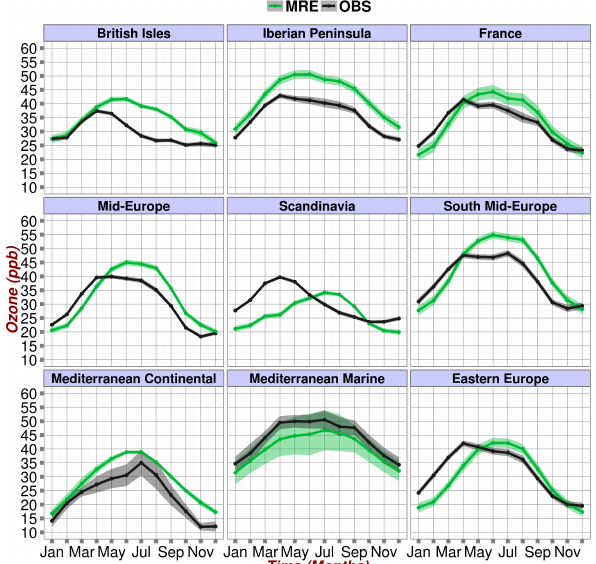
Figure 4. Mean 2003–2012 annual cycle of near-surface ozone for the different European subregions of the MACC reanalysis and ob- servations. The shading areas denote 95% confidence interval of the mean